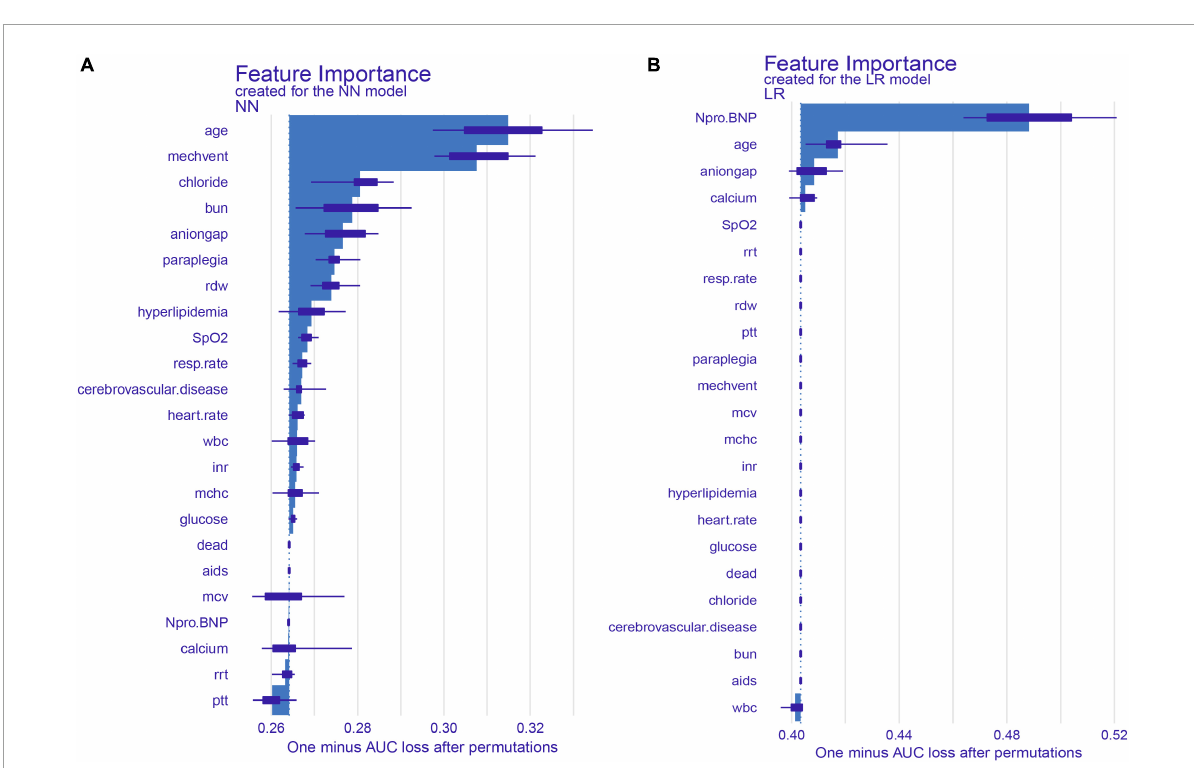
FIGURE3 SHAP summary plot for the top 22 clinical features contributing to the NN (A) and LR (B) model. SHAP feature importance is measured as one minus AUC loss after permutations. This matrix plot depicts the importance of each covariate in the development of the final predictive